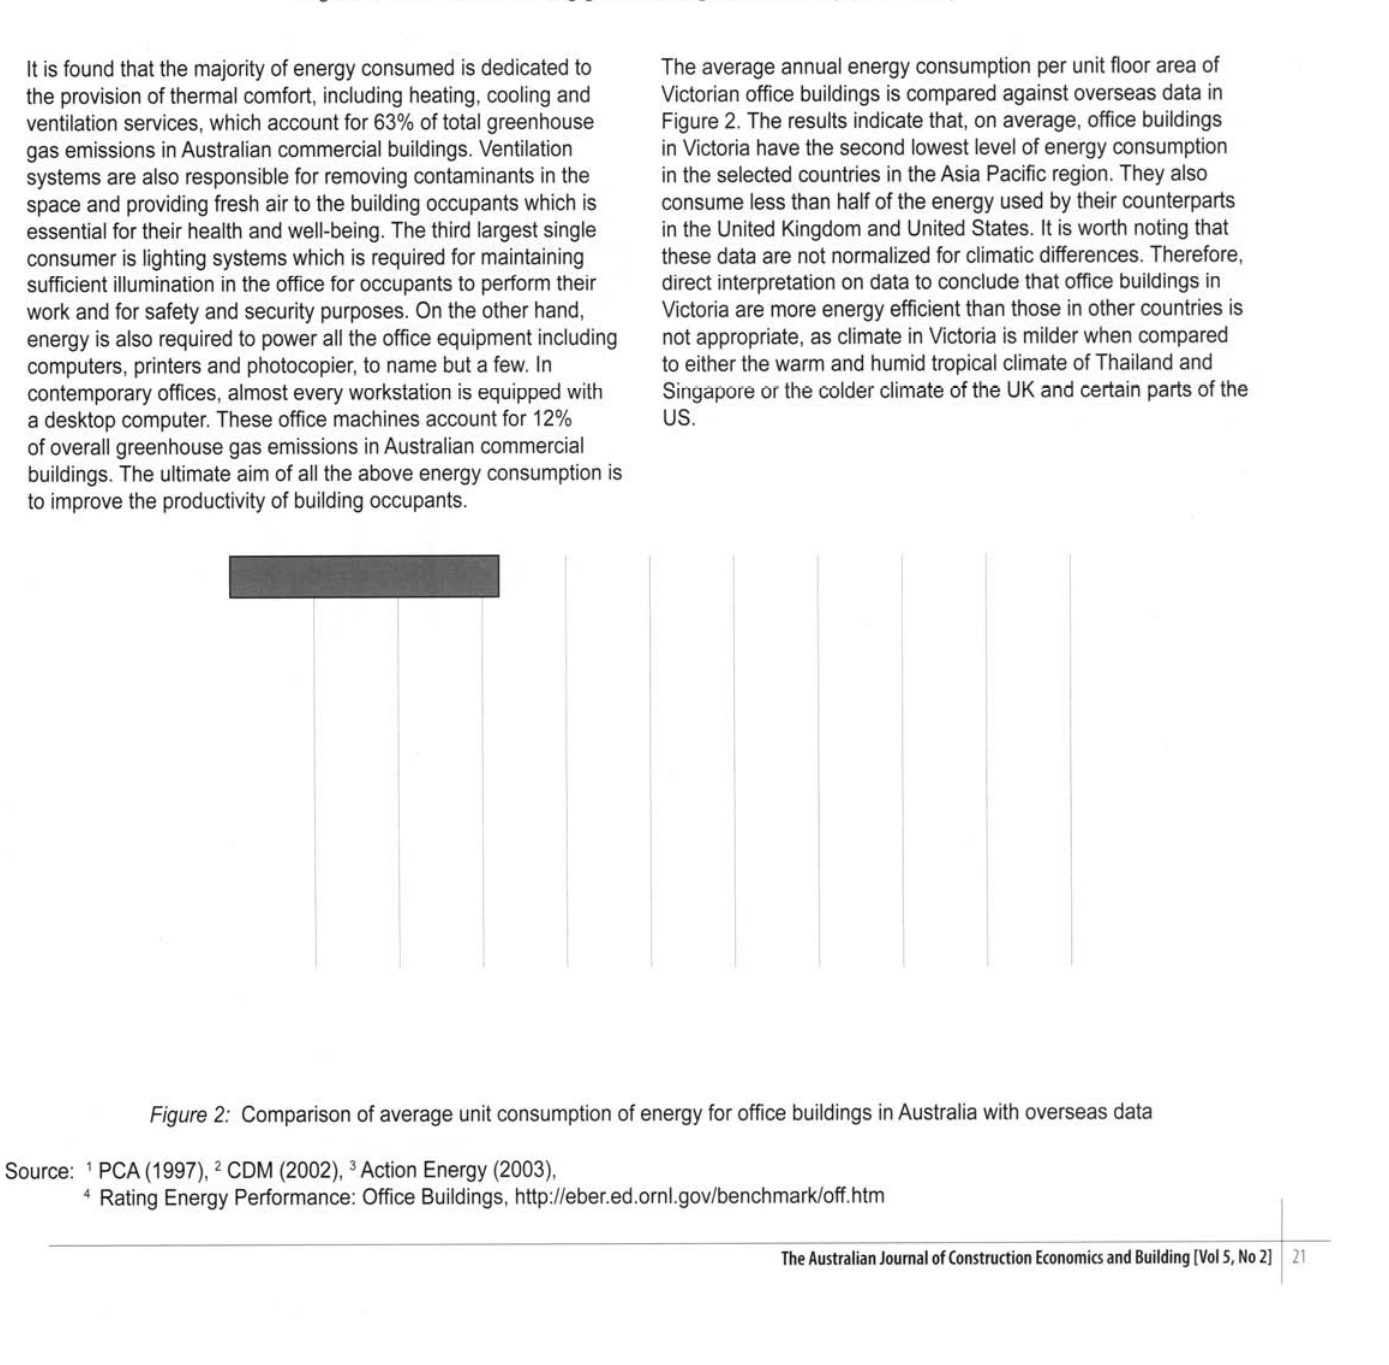
Figure 1: Commercial building greenhouse gas emissions (EMET, 1999)